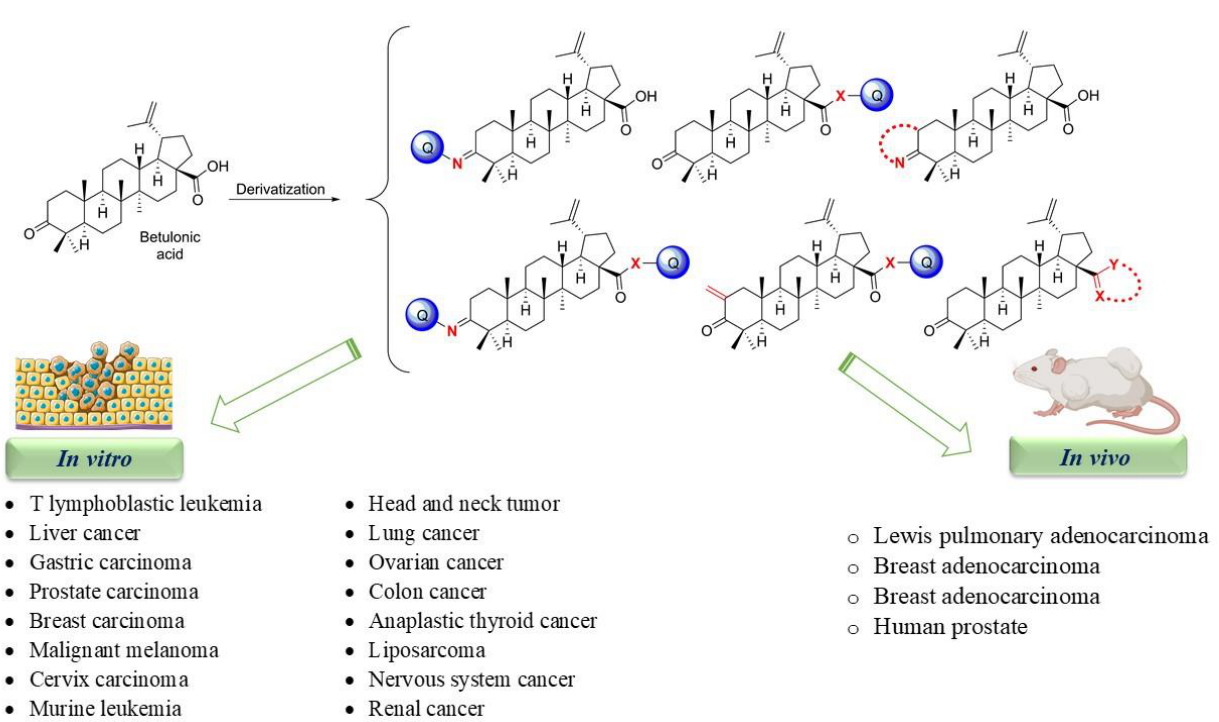
Figure 3. A snap shot of the in vitro and in vivo anticancer effects of the most active derivatives of betulonic acid. Table 3. In vivo studies of betulonic acid derivatives.